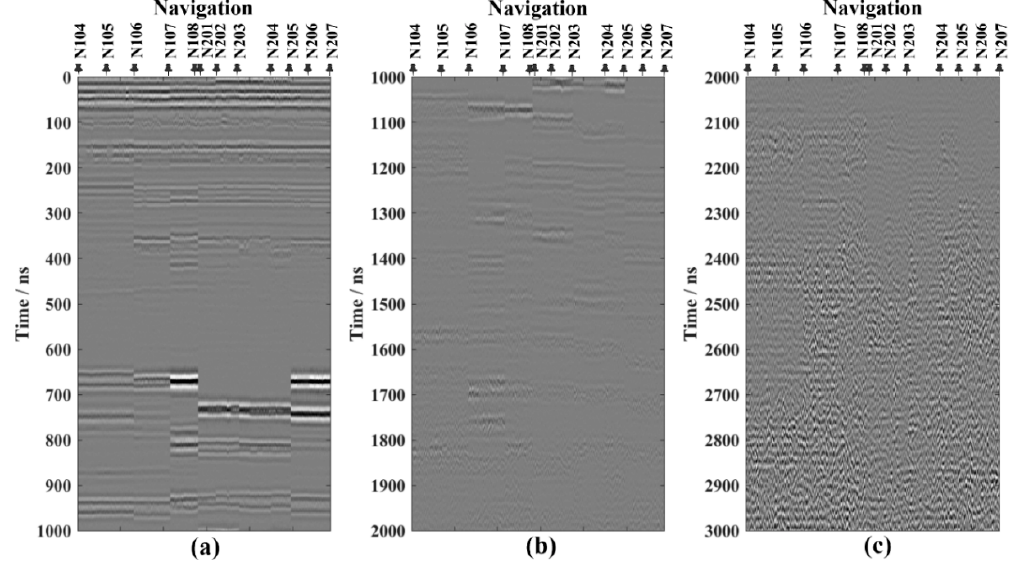
Figure 13. Superimposed component of IMF3 and IMF4. ( a ) 0–1000, ( b ) 1000–2000, and ( c ) 2000–3000 ns.